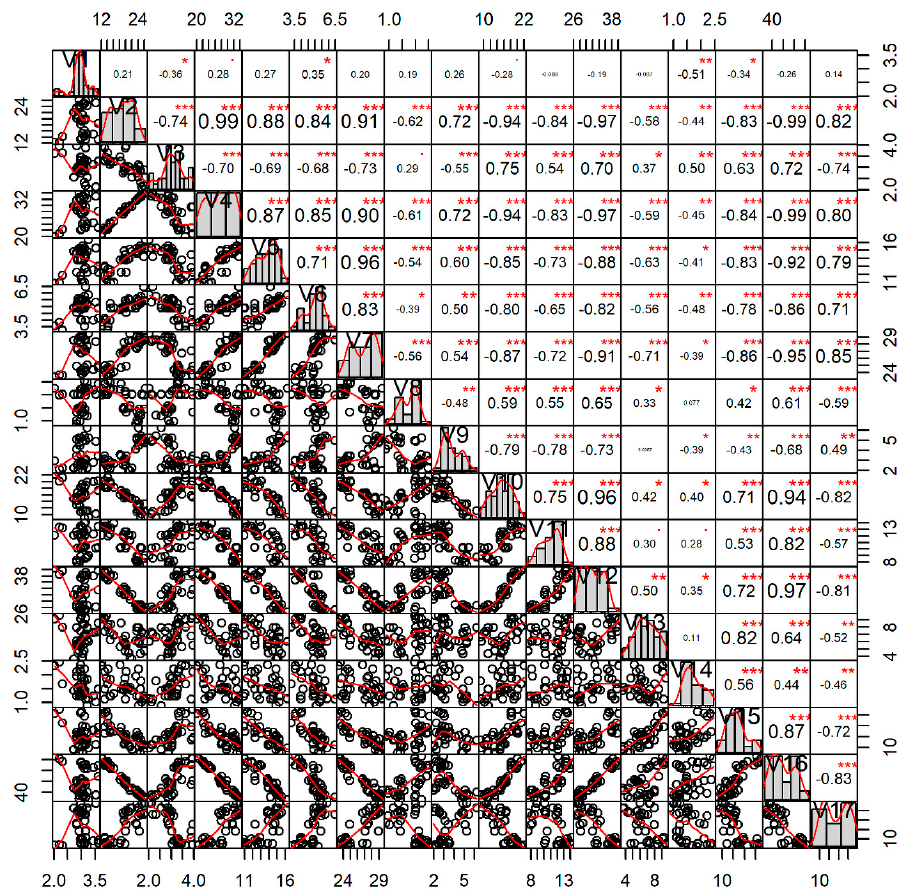
Figure 10. Interrelation among the major gonadal fatty acids (fatty acids >1.0%) and the gonadosomatic index (GSI) of green mussel Perna viridis collected from the coastal waters of Bangladesh. The correlation analysis is based on the three replicated pooled samples (each pooled sample consisted of gonads from five green mussels) for each month (n = 36). Here, the variables’ full